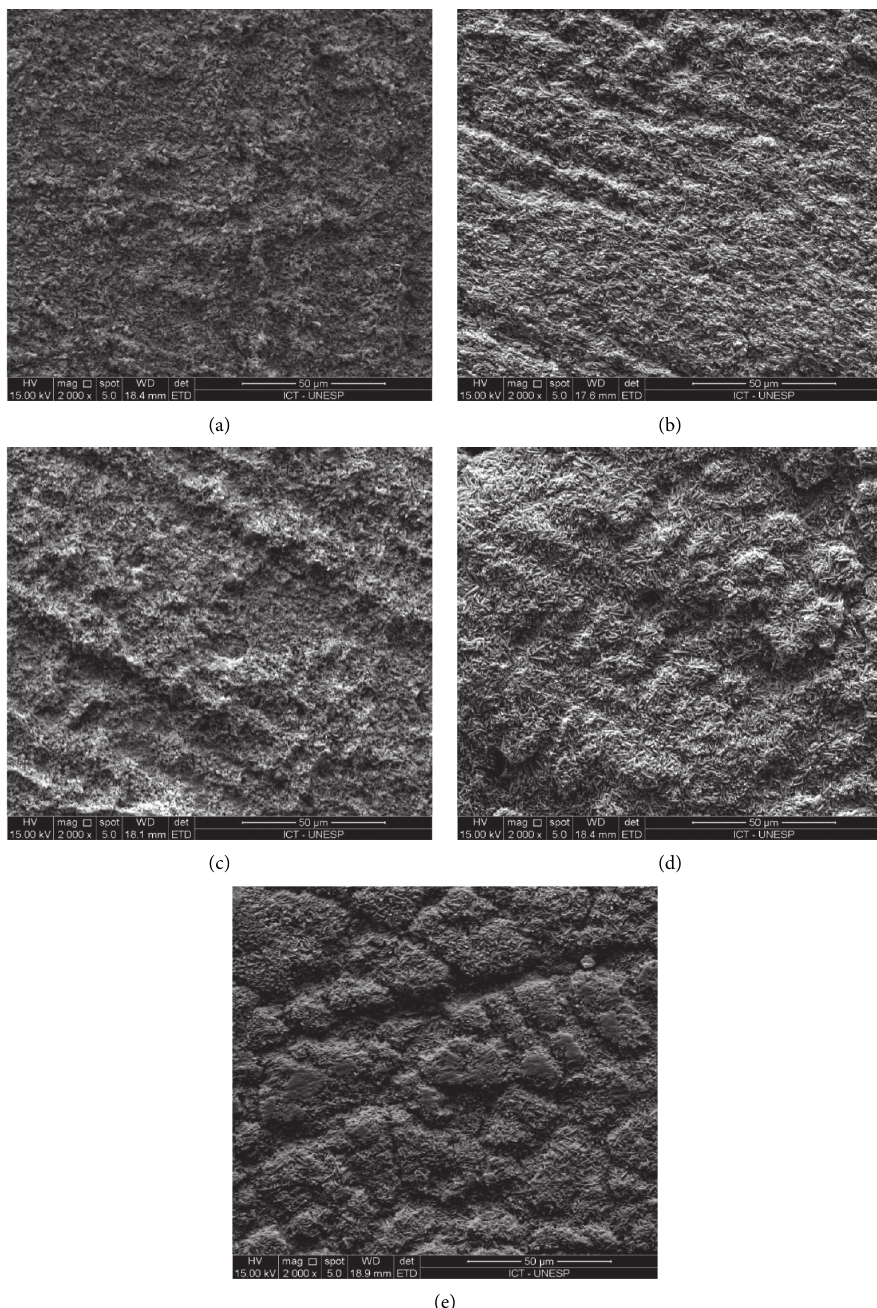
Figure 2: Representative scanning electron microscopy images of the fractured glass-ceramic side of specimens that have been stressed to failure under tension. At high magnification (2,000 × ) lithium disilicate crystallites created by hydrofluoric acid etching could be seen after the resin cement was dislodged from the bonded interface. (a) Control (2,000X). The lithium disilicate crystallites created by hydrofluoric acid etching. (b) Nd:YAG laser +Sil group: greater roughness can be seen compared to the control group, and it is related to the laser application. (c) Sil +Nd:YAG laser group: the lithium disilicates crystallites created by the laser application. (d) Graphite +Sil +Nd:YAG laser group: cluster-like lithium disilicates crystallites formed by the increased absorbance of the laser caused by the presence of the graphite. (e) Graphite +Nd:YAG laser+Sil group: demonstrating a great amount of deep scratches showing a great loss of the structure of the ceramic and thus did not improve the bond